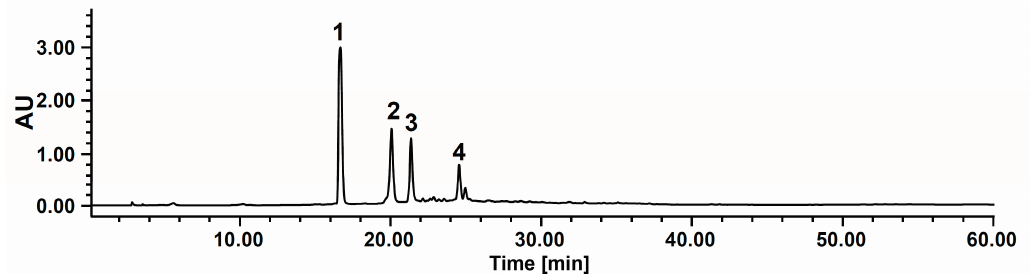
Figure 2. HPLC chromatogram of the acetone-soluble extract of fermented C. sinensis leaves. Peaks 1 : caffeine, 2 : ( − )-epigallocatechin 3- O -gallate, 3 : ( − )-gallocatechin 3- O -gallate, and 4 : ( − )-epicatechin 3- O